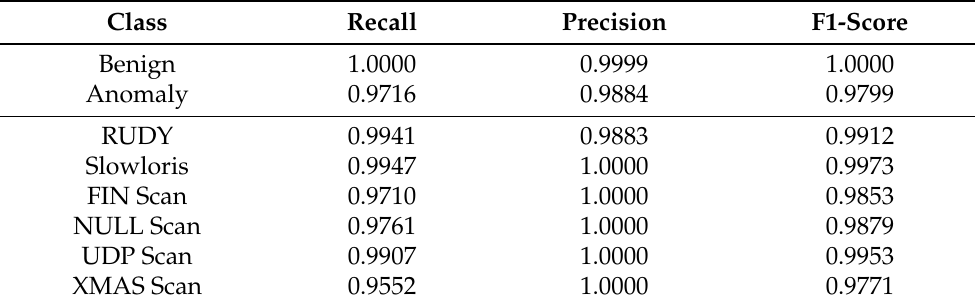
Table 2. Detection effectiveness of the proposed approach (SIMARGL2021 dataset).